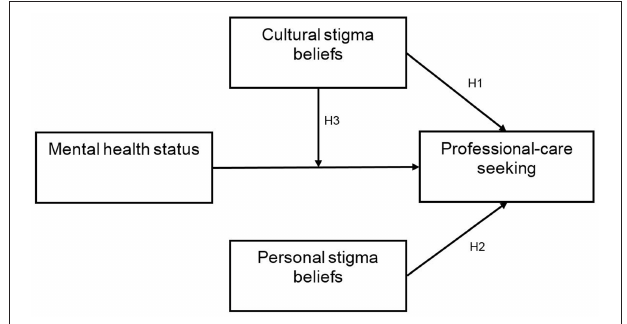
FIGURE 1 | Personal and cultural stigma beliefs and professional-care seeking: Conceptual model and main hypotheses.